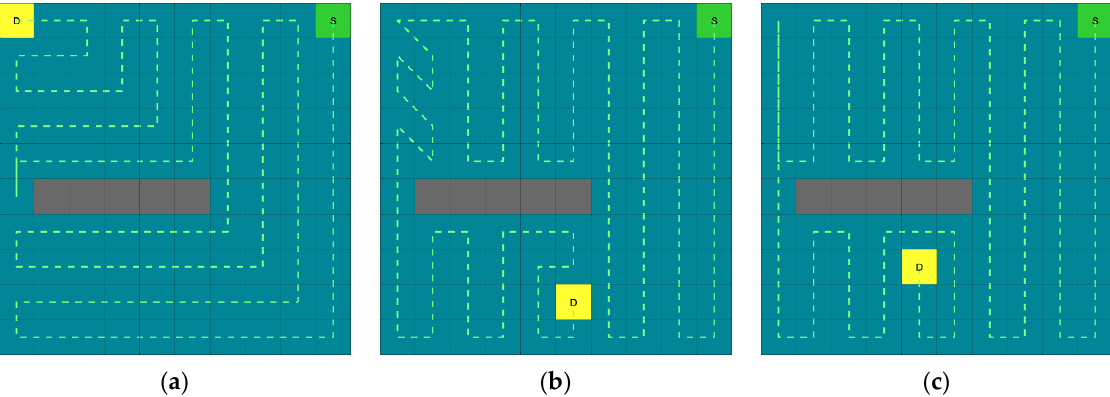
Figure 6. Influence of the covering direction term on the generated path: ( a ) BINN algorithm. ( b ) CCNN algorithm without covering direction term. ( c ) CCNN algorithm with covering direction term.